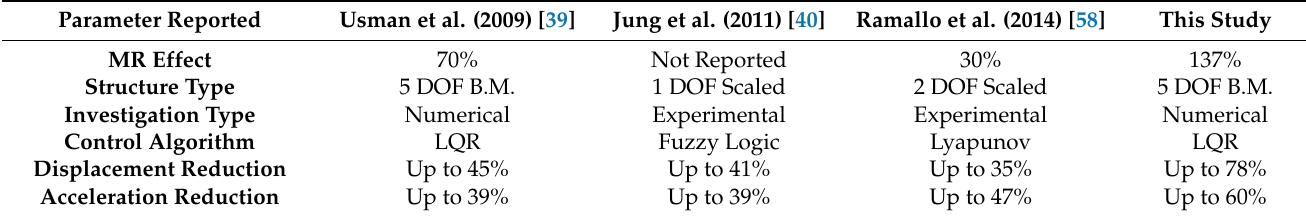
Table 7. Comparison with previous